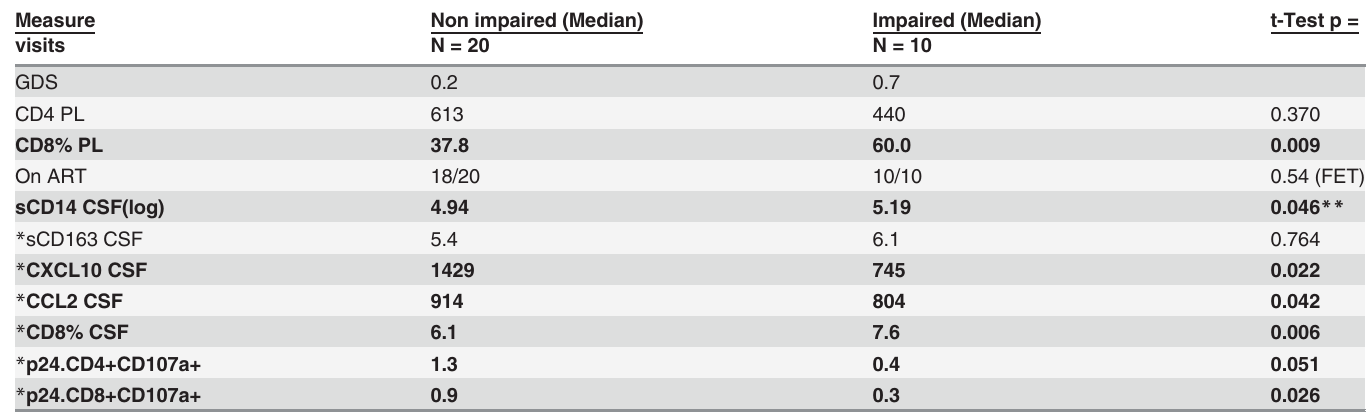
Table 5. When HIV RNA is suppressed, NC impairment is associated with higher CD8+ T-cell levels, higher CD14 levels, lower T-cell lytic activity and lower beta chemokine levels in CSF.